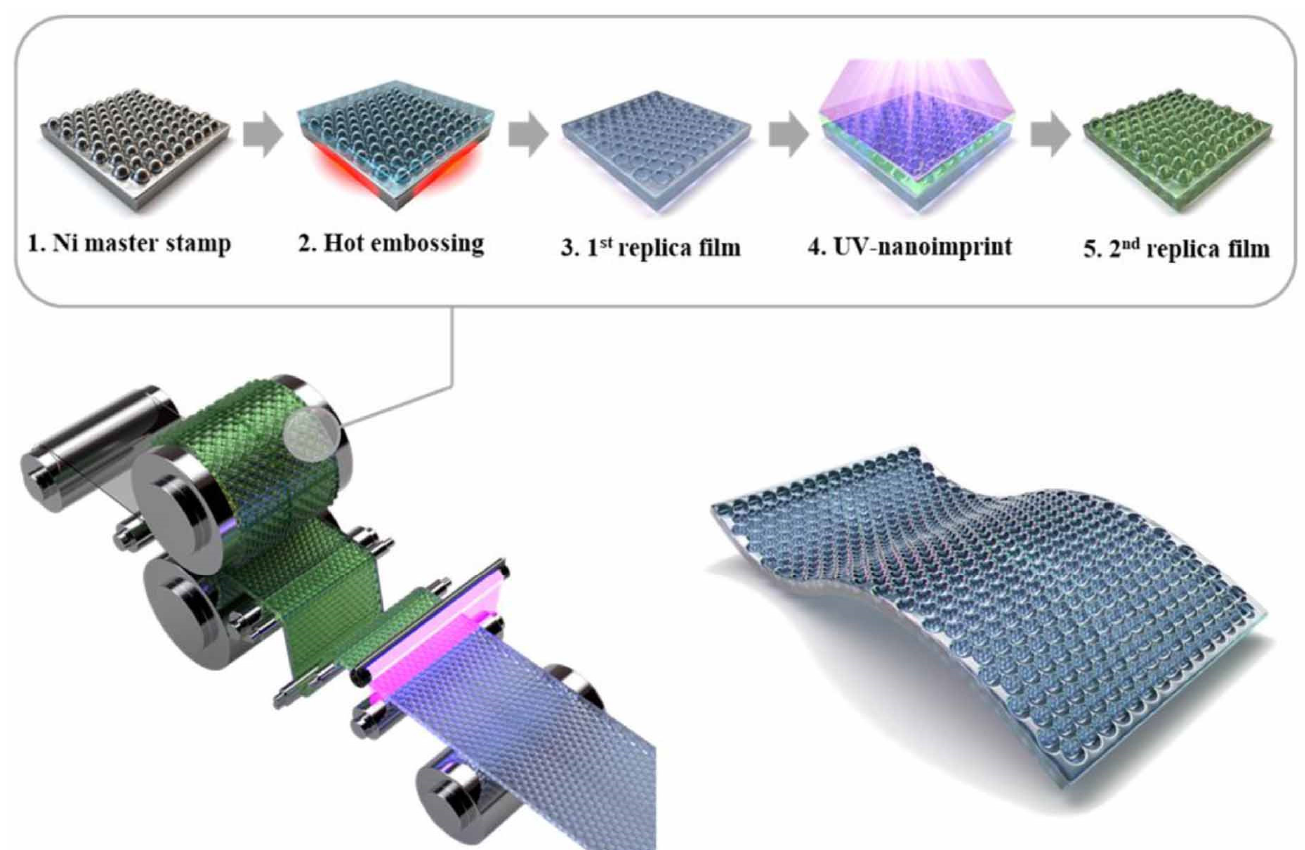
Figure 6. Schematic representation of the roll-to-roll printing process of the moth-eye film from Ju et al. Reprinted with permission from Ref. [53]. 2020, IOP Publishing.